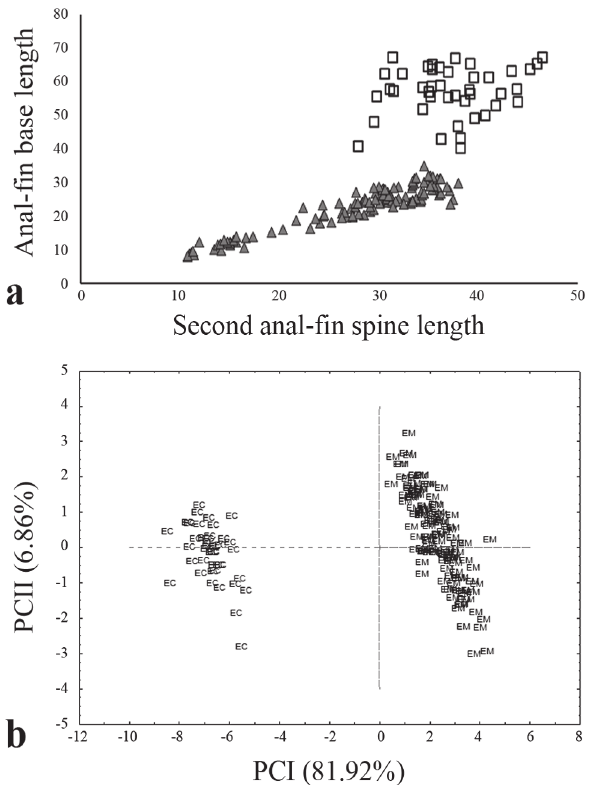
Fig. 2. a ) Graphical index for discrimination of Eugerres castroaguirrei (squares, n = 42) and E. mexicanus (triangles, n = 122), provide by the biplot of second anal-fin spine length against anal-fin base. b ) Plot of principal components (PC) scores for E. castroaguirrei (EC) and E. mexicanus (EM) from the southeastern of Mexico and northern